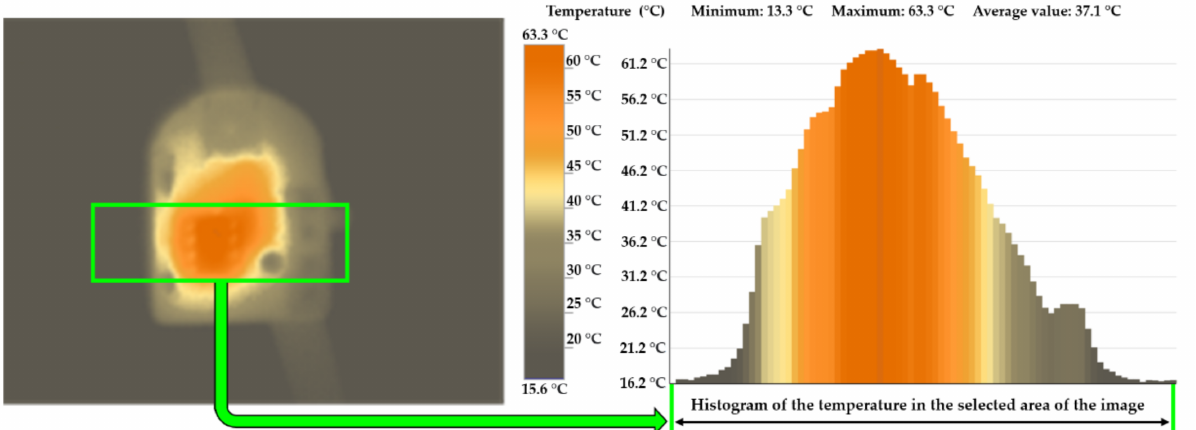
Figure 18. Heat diagram of IO NE555P exposed to EMP for 2 s at a distance of 1.1 m. When the electronic circuit was exposed to EMP at a short distance (25 cm) from the microwave power generator antenna, all the passive components (resistor, capacitor, coil, etc.), from which the entire electronic circuit was assembled, were also destroyed. Figure 19 shows a detailed view of the resistor after the irreversible destruction. This resistor was